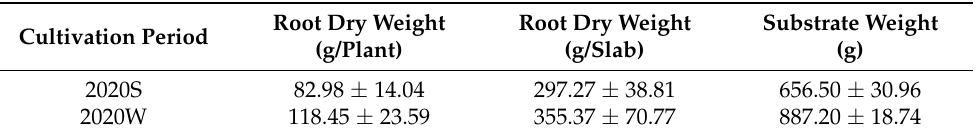
Table 2. Root and substrate weights collected from destructive investigations from 26 February subtracted from the total weights to calculate crop fresh